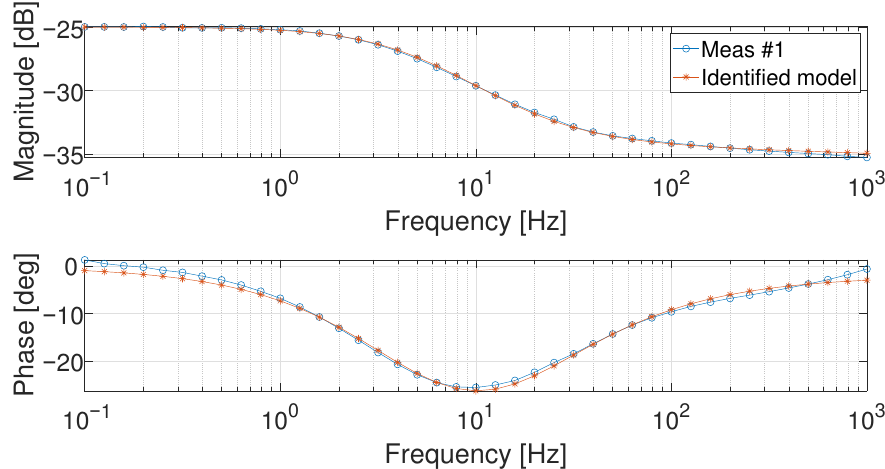
Figure 9. Bode diagrams of the identified Meas #1 at 1A.